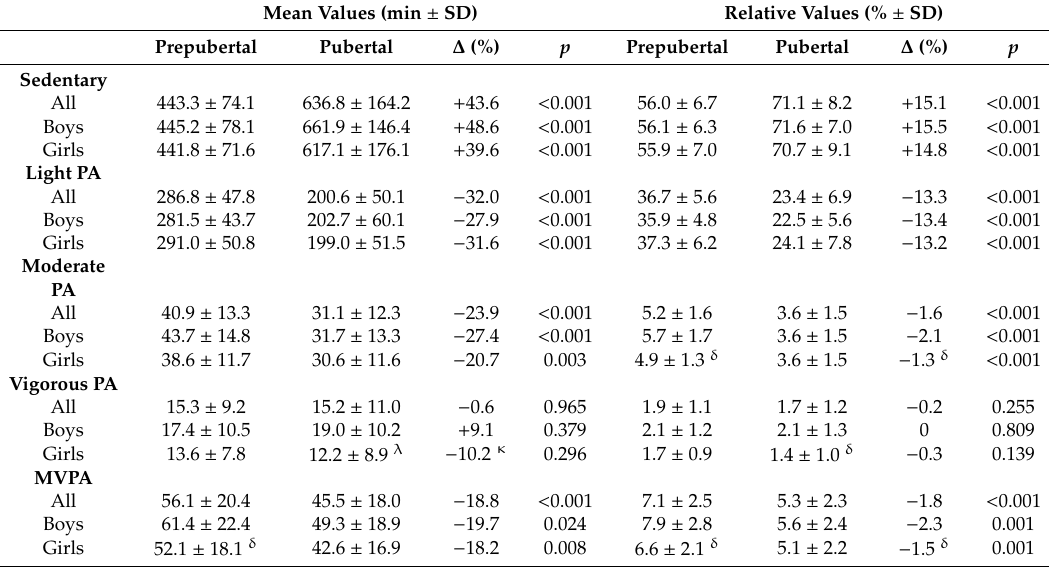
Table 2. Di ff erences in physical activity levels between prepubertal and pubertal periods measured in mean minutes and relative percentages in the longitudinal sample (n = 75).